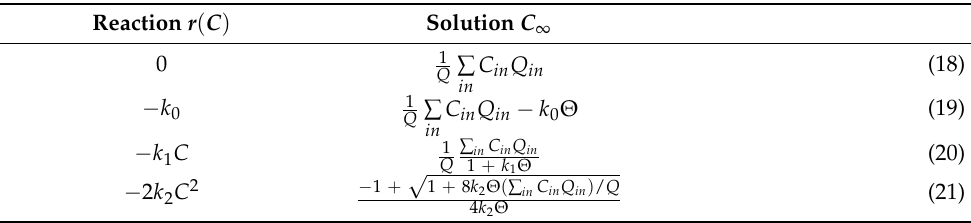
Table 3. Solutions for the steady outlet concentration C ∞ in the CMFR for the different reaction